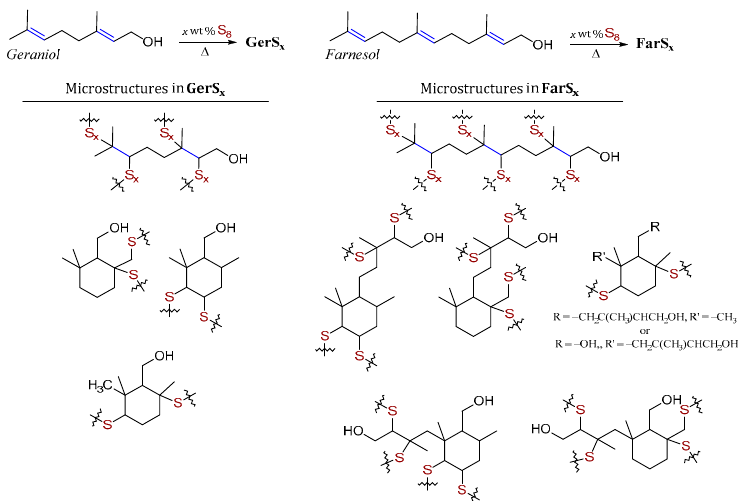
Scheme 2. Reaction of terpenoids such as geraniol and farnesol with sulfur leads to HSMs GerS x and FarS x comprising several microstructures resulting from a combination of inverse vulcanization and intramolecular cyclization reactions.